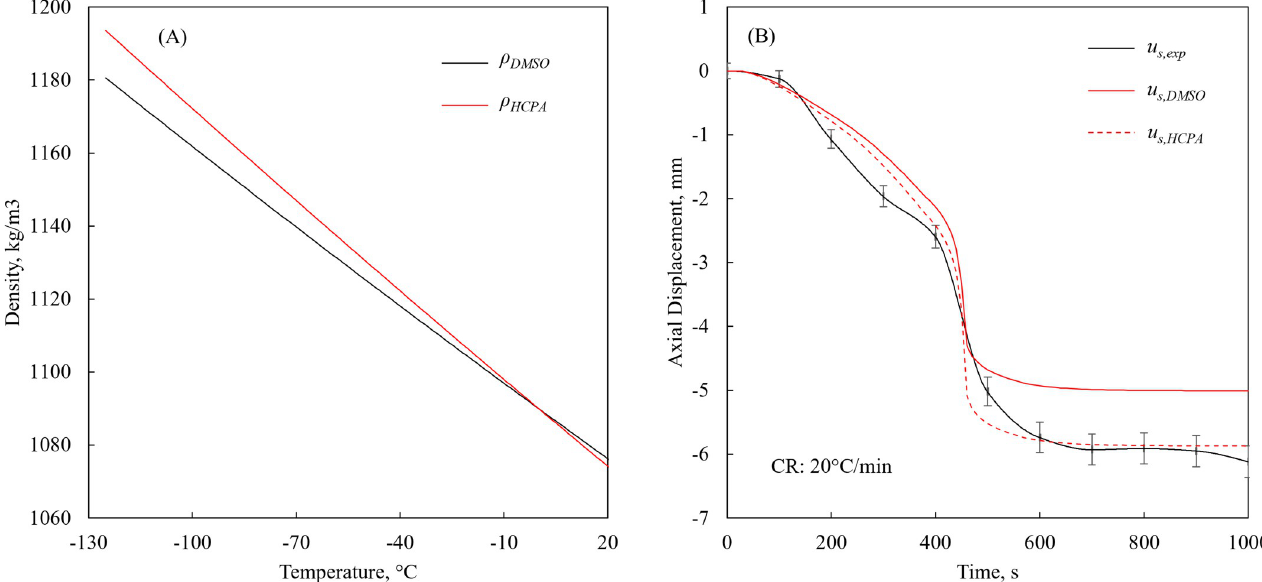
Fig 6. A 2D TF modeling case study on the effect of density variation with temperature, where HCPA is a hypothetical CPA having similar properties to 7.05M DMSO but 15% steeper variation. (A) temperature-dependent density; (B) experimental results used as the base for this case study, representing the worst match between modeling and experimental data in Fig 5 (cooling rate of 20F0B0C/min). The steeper-slope density curve results in absolute difference in density in the range of 0 to 0.88%, and a relative density variation of 0 to 14.5% between the temperatures 0˚C to -100˚C, respectively.